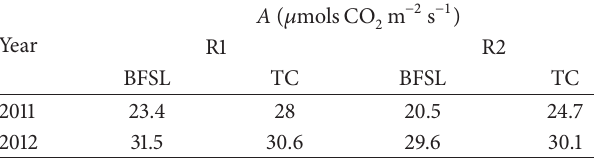
Figure 1: Mean 𝐴 at growth stages R1 and R2 of 10 maize hybrids grown under furrow irrigation on sites, a Bosket fine sandy loam (BFSL) and a Tunic clay (TC) soil near Stoneville, MS, in 2011 and 2012. Means of 3 plants, 4 replications, and 2 years for all data. Means for R1 are for 1 site, while for R2, 2 sites. Only means at growth stage R1 were significantly different ( 𝑃 ≤ 0.05 ( ± SD = 1.51)). Table 2: Mean A at growth stages R1 and R2 of 10 irrigated maize hybrids grown on a Bosket fine sandy loam (BFSL) and a Tunica clay (TC) soil in 2011 and 2012 near Stoneville, MS † .